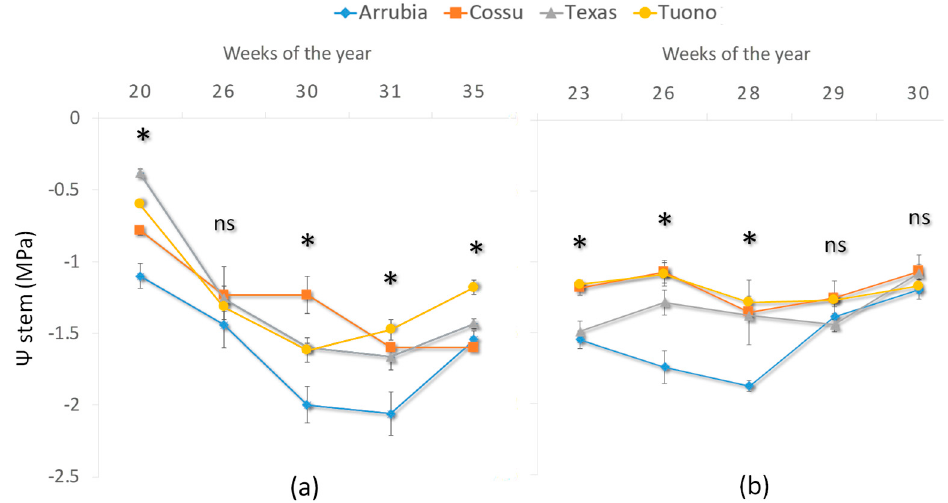
Figure 3. Patterns of midday stem water potential in each cultivar during the growing seasons 2020 ( a ) and 2021 ( b ). Values are mean ± standard error. Significant differences for p -value of 0.05 are represented by * and ns indicates not significant differences among cultivar.